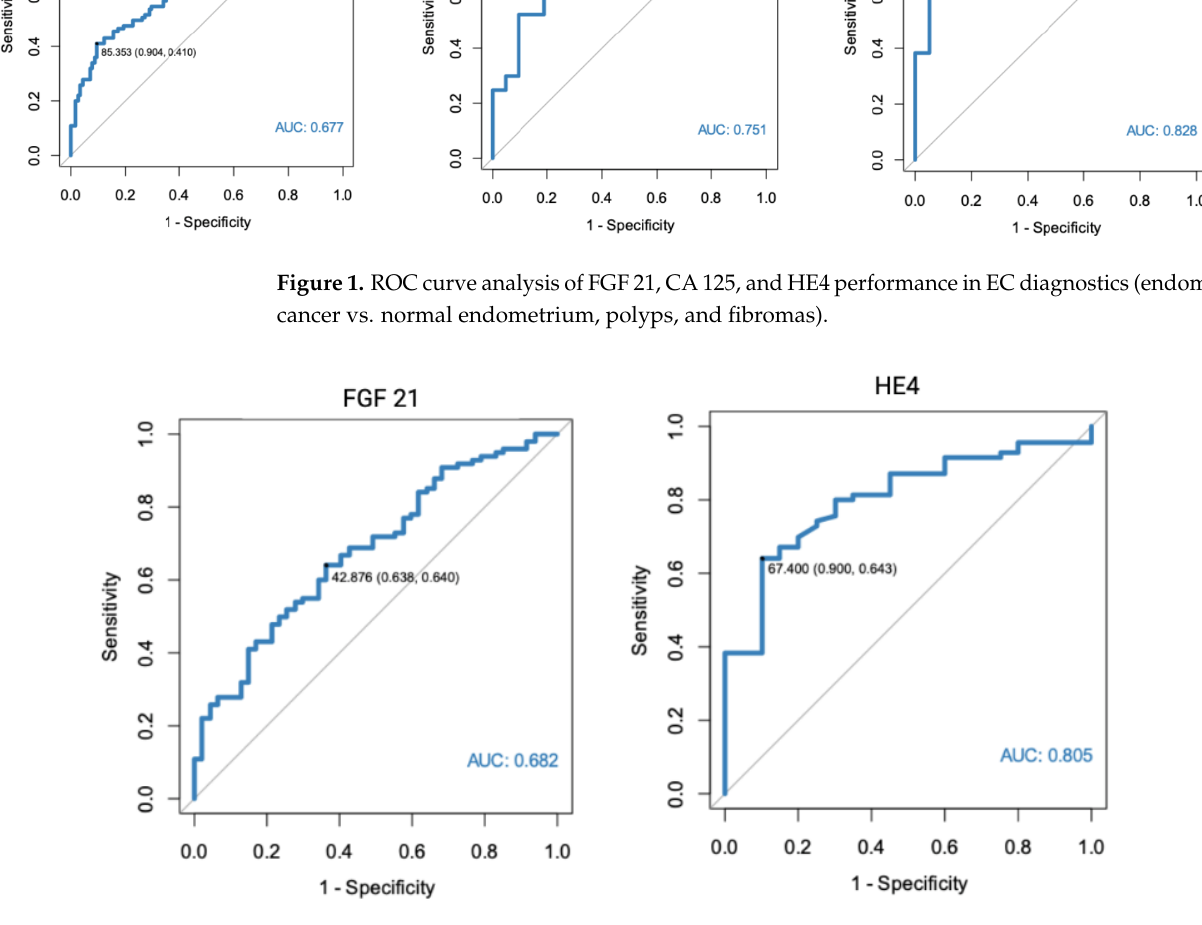
Figure 2. ROC curve analysis of FGF 21 and HE4 performance in EC diagnostics (endometrial cancer vs. normal endometrium).